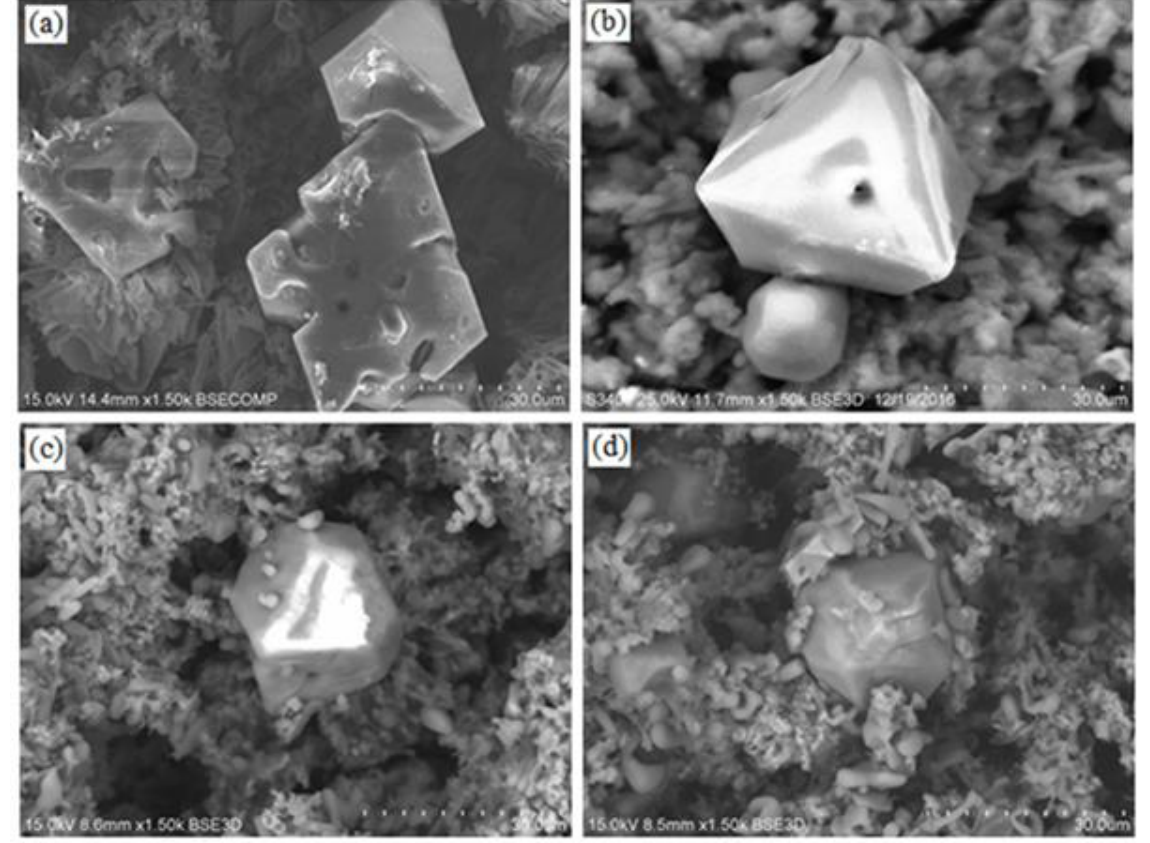
Fig. 3. 3D morphologies of primary Mg 2 Si crystals before (a and c) and after (b and d) solution heat treatment with Gd concentration of: (a, b) 0 wt. %, (c, d) 1.0wt.